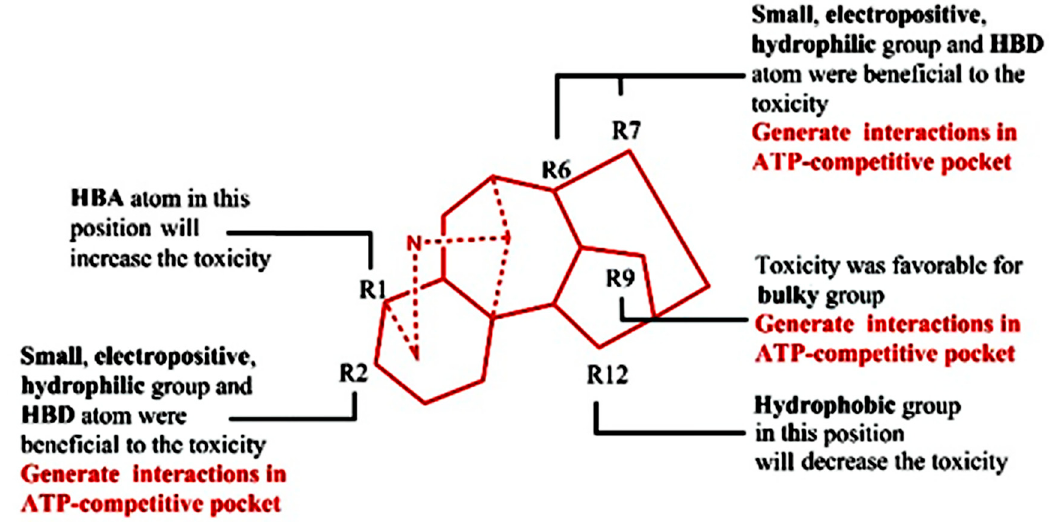
Figure 10. Crucial requirement of cardiotoxicity mechanism was obtained from the ligand-based 3D-QSTR and structure-based molecular docking study.